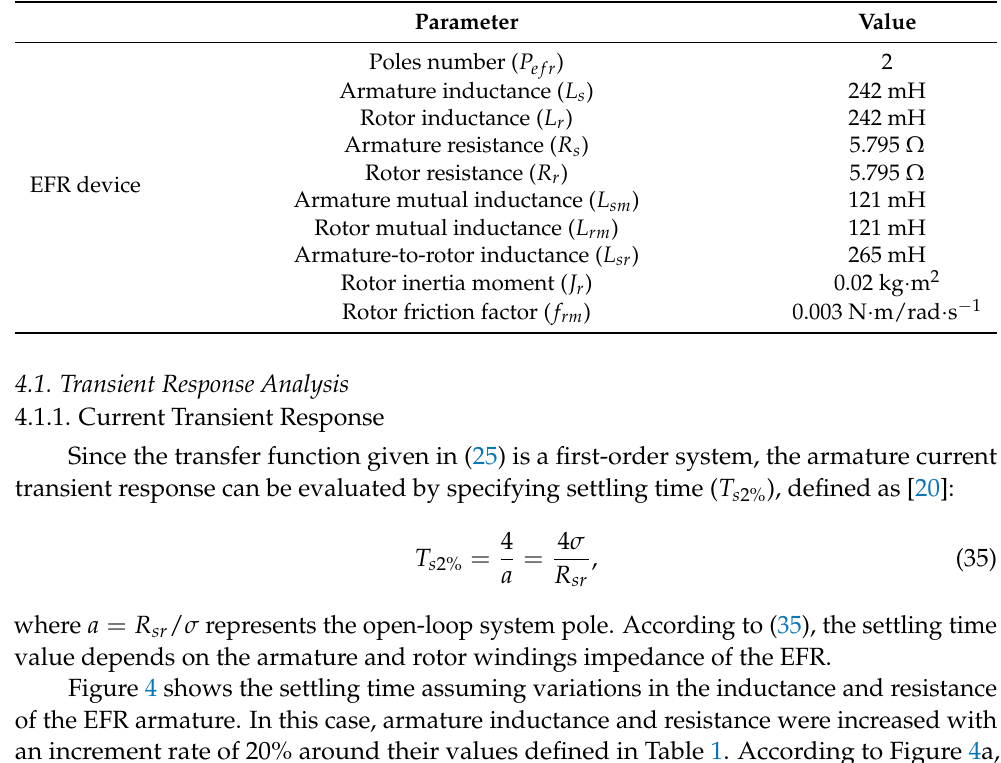
Table 1. EFR’s parameters.